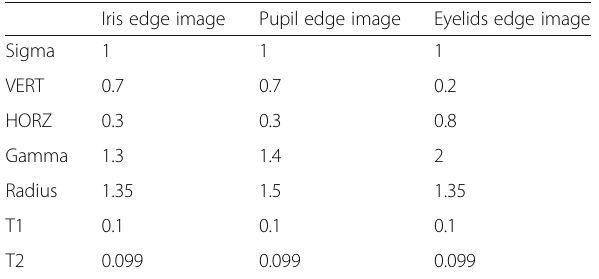
Table 3 Typical parameter values of canny edge, gamma, radius, and thresholding